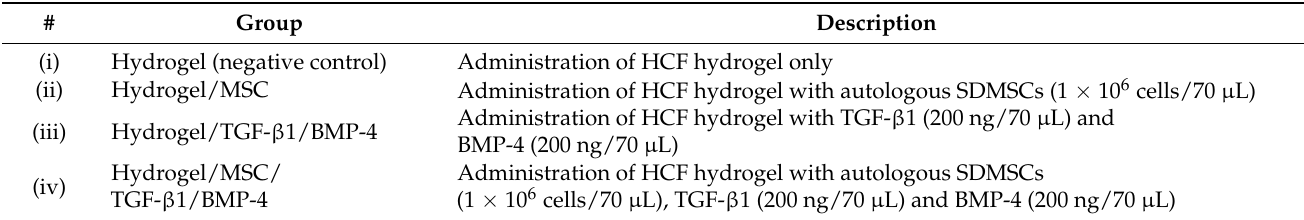
Table 1. Experimental groups of rabbits for hydrogel